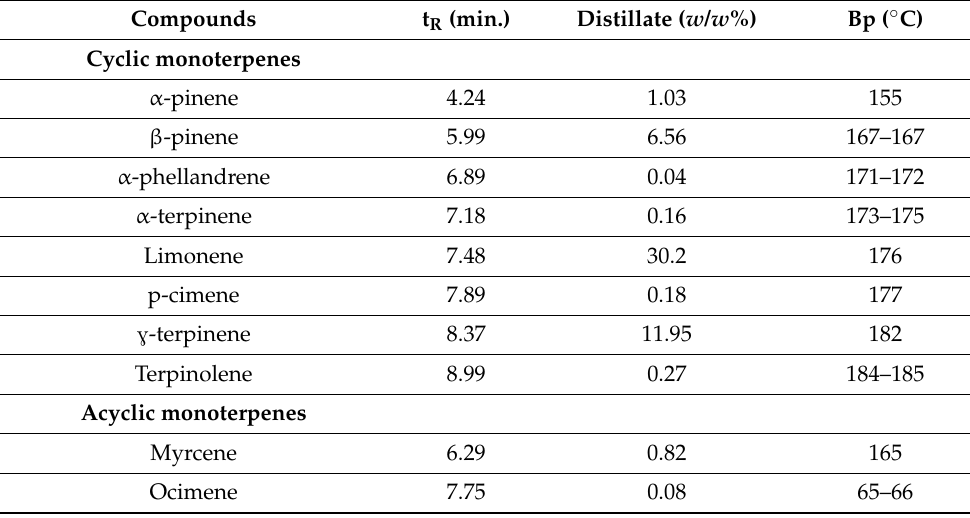
Table 1. Chemical characterization of the distilled extract of